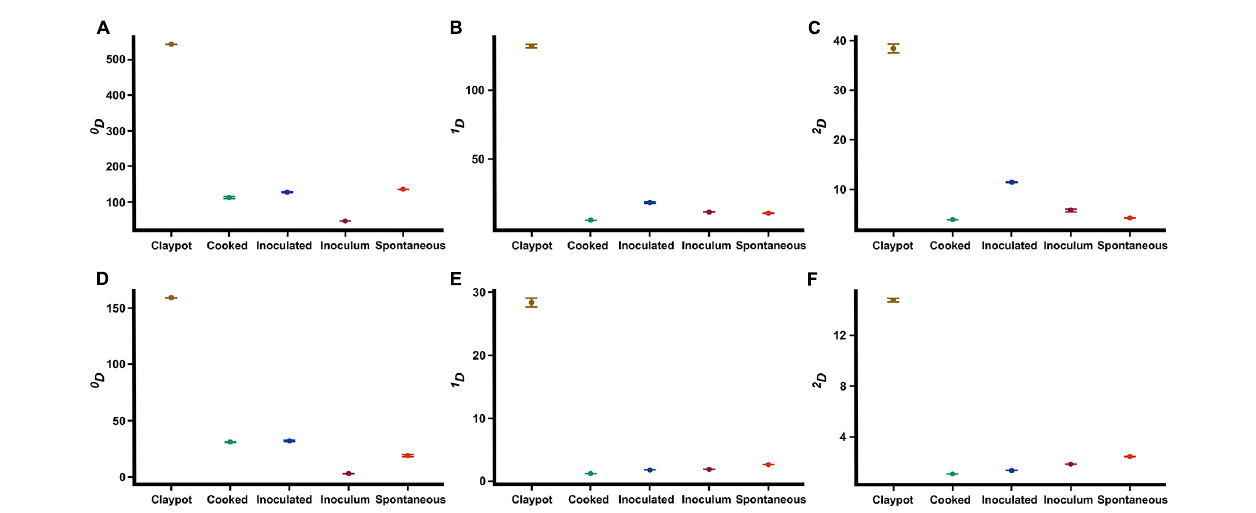
FIGURE 2 | Comparison of the richness and alpha diversity of the bacterial (A–C) and fungal communities (D–F) between the different colonche management practices estimated with the Hill numbers ( q D ). Interval plots of richness (A,D) , effective number of common amplicon sequence variants (ASVs) (B,E) , and effective number of dominant